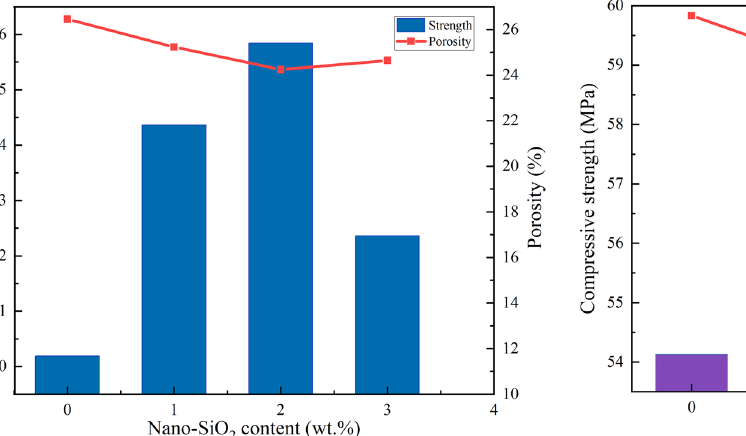
Figure 18: Relations between 28 days strength, porosity and nano - SiO 2 content ( slag/ fl y ash = 30/70 ) [ 98 ]